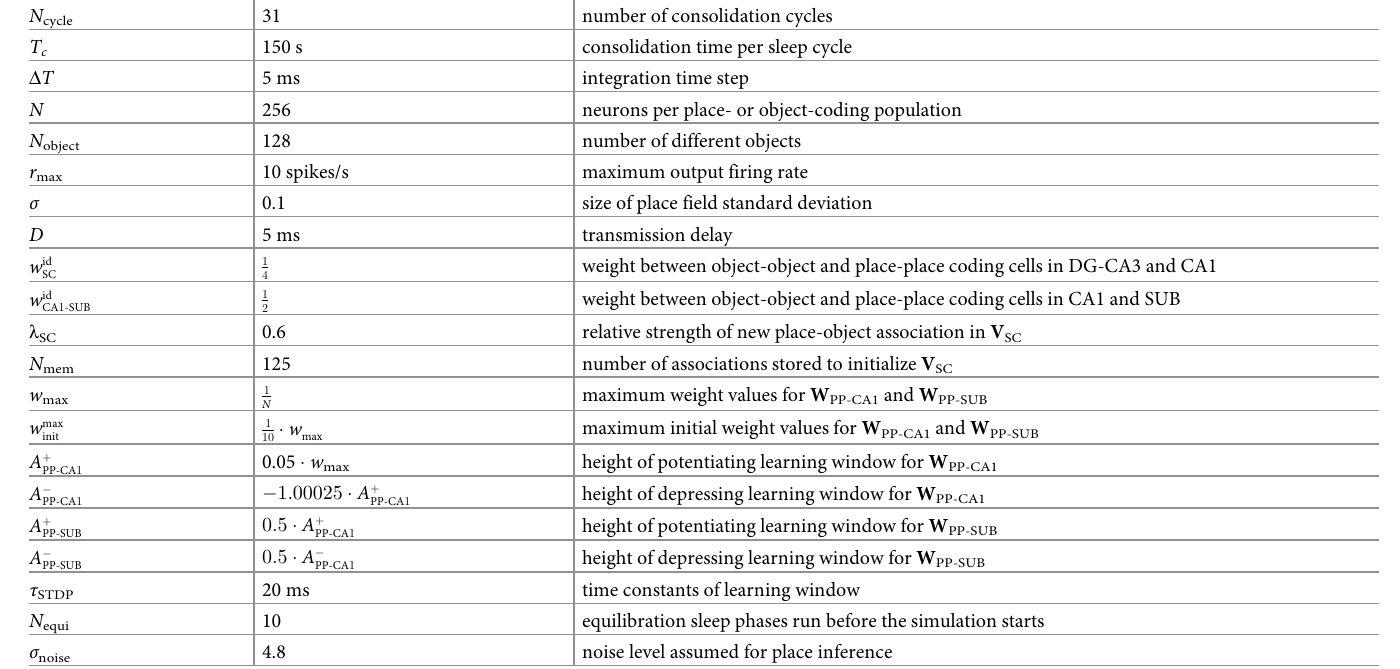
Table 1. Parameters for simulations shown in Fig